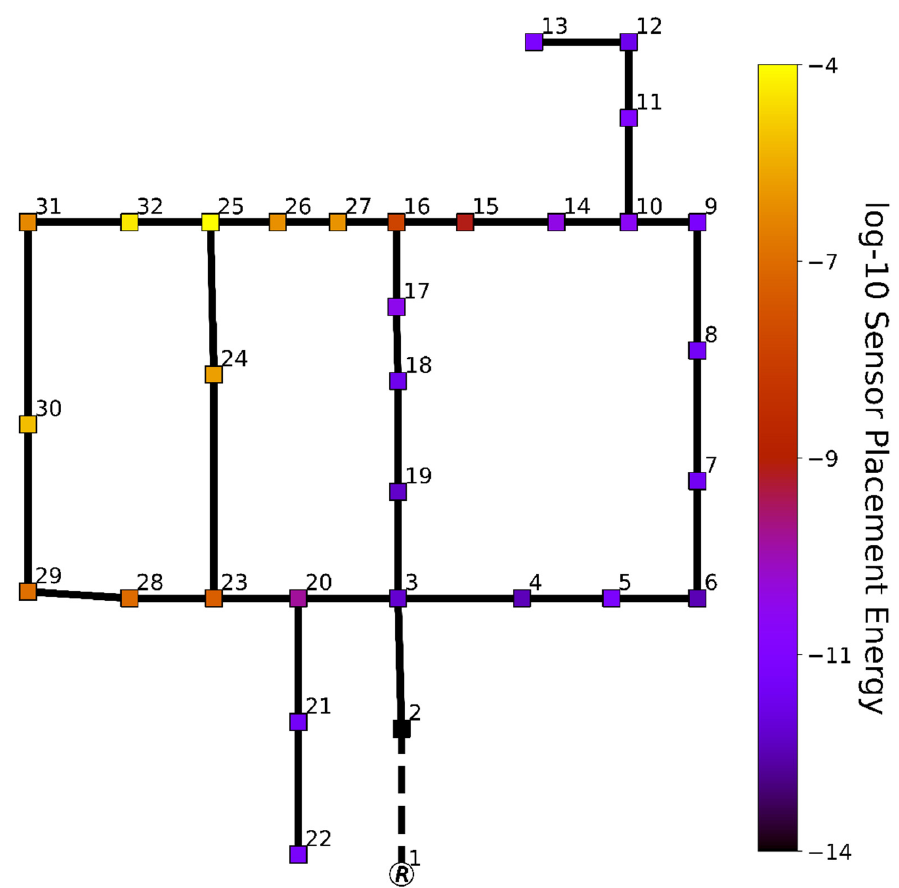
Figure 4. Comparison of possible pressure sensor placements in the Hanoi network. Possible pressure sensor junctions (squares) are colored based on 10-log output energy associated with placement of a sensor in that junction. Those conduits (black lines) attached to a reservoir ( R ) are already metered (dashed black lines).